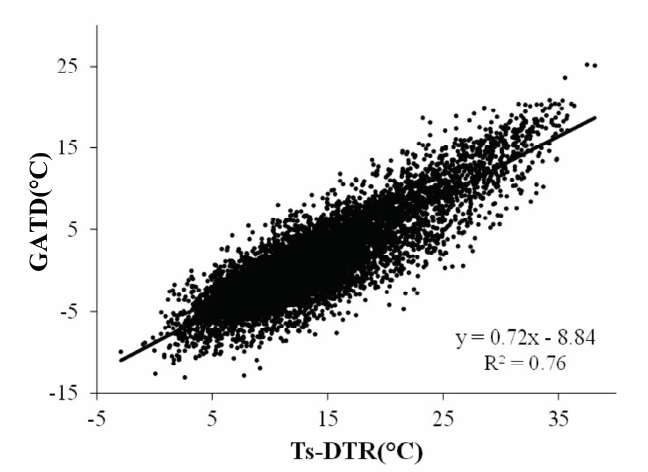
Figure 7. Scatterplot of Ts-DTR vs. GATD (°C) for all station from 2008 to